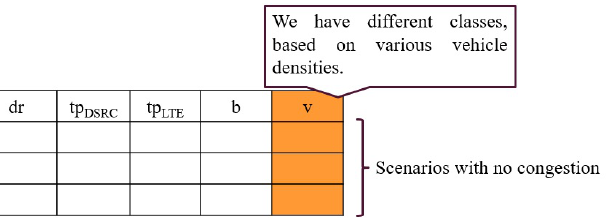
Figure 2. Structure of data set used for the Conditional Generative Adversarial Network